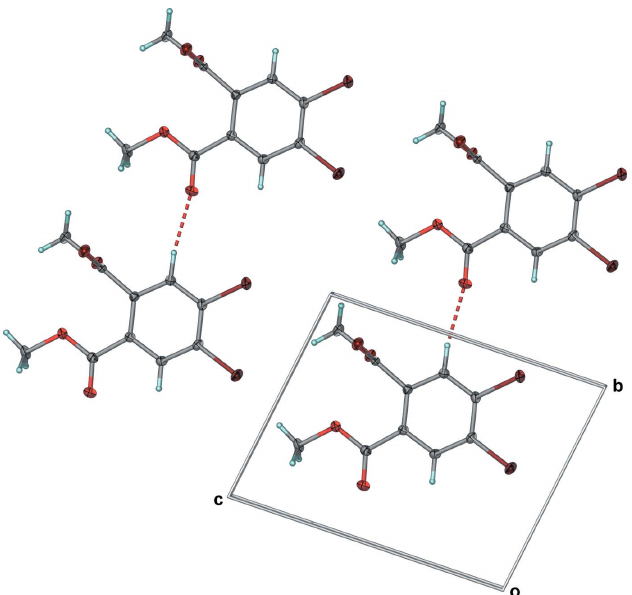
Figure 3 Projection of 1 within the bc -plane showing the C—H (cid:4)(cid:4)(cid:4) O hydrogen bonding between neighboring molecules along b to form one-dimensional arrays. Anisotropic displacement ellipsoids have been set to the 50% probability level. Dashed lines represent hydrogen bonds.